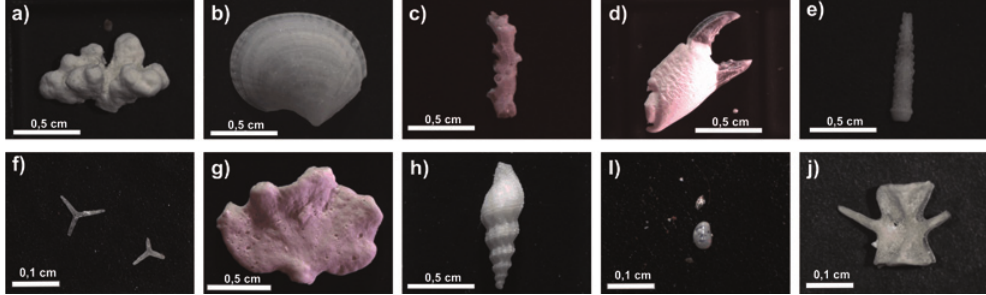
Figure 14 - Diversity of biogenic carbonate particles of Rocas Atoll. a) Coralline algae; b) Bivalve; c) Bryozoans;